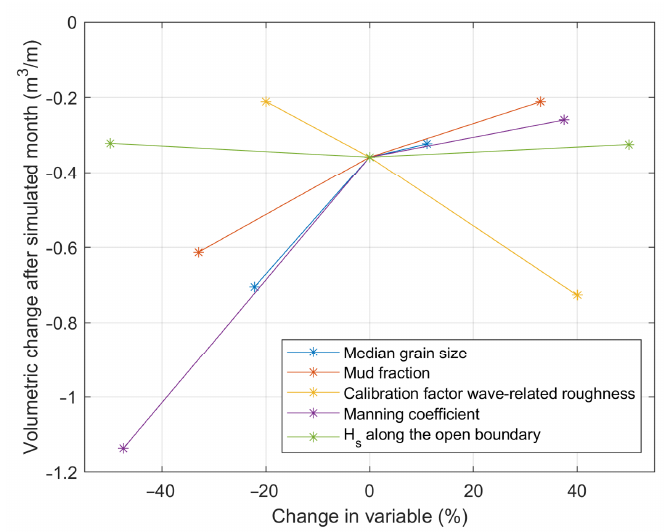
Figure 12. A sensitivity analysis with the width-averaged volumetric change of the salt marsh as indicator. The default case (0% change in variable) is the same simulation as in Section 3.2.1. The analysis is performed for the median grain size ( D 50 ) , mud fraction ( p m ) , calibration factor for wave-related roughness ( RWAVE ), Manning coe ffi cient (n), and significant wave height along the open boundary ( H s , BC ). Further information on the parameters is available in Appendix A (Table The sediment transport formulation of van Rijn (1993) is used to derive morphological development based on the hydrodynamic conditions. This formulation has reduced accuracy for bed material with (cid:1830) (cid:2873)(cid:2868) < 200 (cid:2020)(cid:1865) . In addition, the magnitude of sediment transport is sensitive towards wave-related bed-form roughness, an input parameter of which little data are available [31]. The